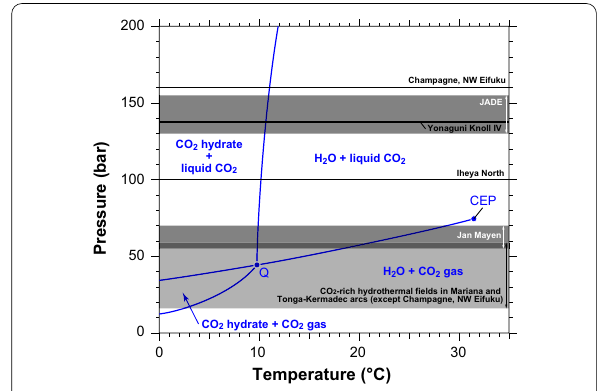
Fig. 3 A relationship between seafloor pressures of CO 2 -rich hydrothermal fields and phase relations in the CO 2 –H 2 O system (modified from Spycher et al. 2003). CO 2 -rich hydrothermal systems seem to host a L/SC-CO 2 pool when seafloor pressures exceed the critical pressure of CO 2 -rich fluid. In contrast, Jan Mayen field in the Arctic Mid-Ocean Ridge (Pedersen et al. 2010; Stensland et al. 2019) and CO 2 -rich hydrothermal fields in the Mariana (except Champagne field) and Tonga-Kermadec arcs (Lupton et al. 2008) discharge CO 2 -rich fluids as gas bubbles (with/without CO 2 hydrate). Q, a quadruple point; CEP, a critical end point for the CO 2 –H 2 O